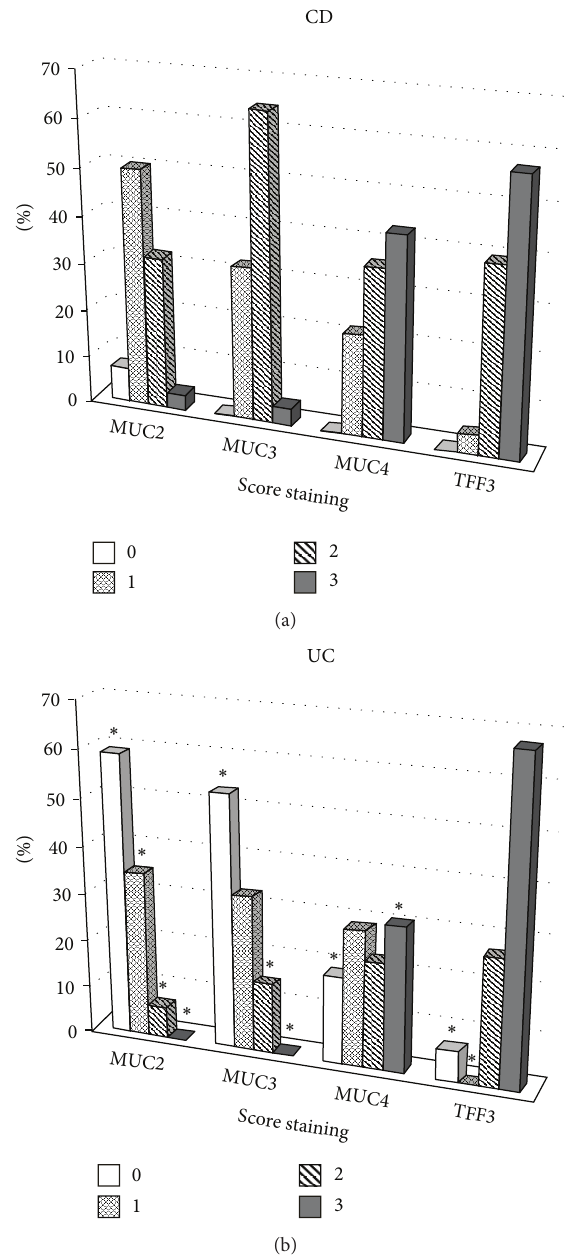
Figure 1: General mucins (MUC2-4) and TFF3 expression in CD (a) and UC (b) patients. Histological score of the staining intensity from 0 to 3 ((b) ∗ 𝑃 ≤ 0.05 compared to CD, Mann Whitney 𝑈